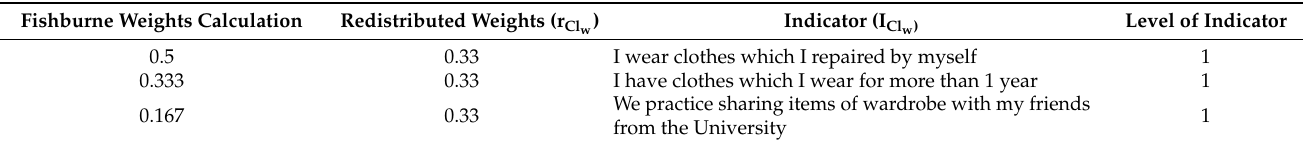
Table 31. Reasoning indicators for wearing habits.